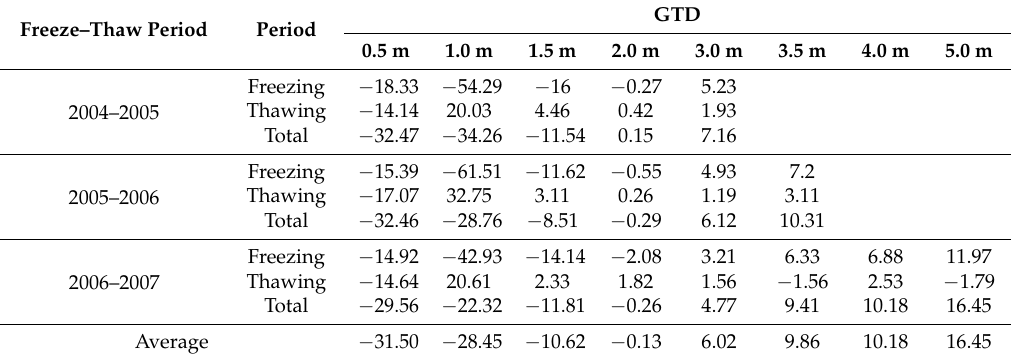
Table 11. Results of the difference between phreatic evaporation and recharge to groundwater with fine sand during freeze–thaw periods. Unit: Millimeters.